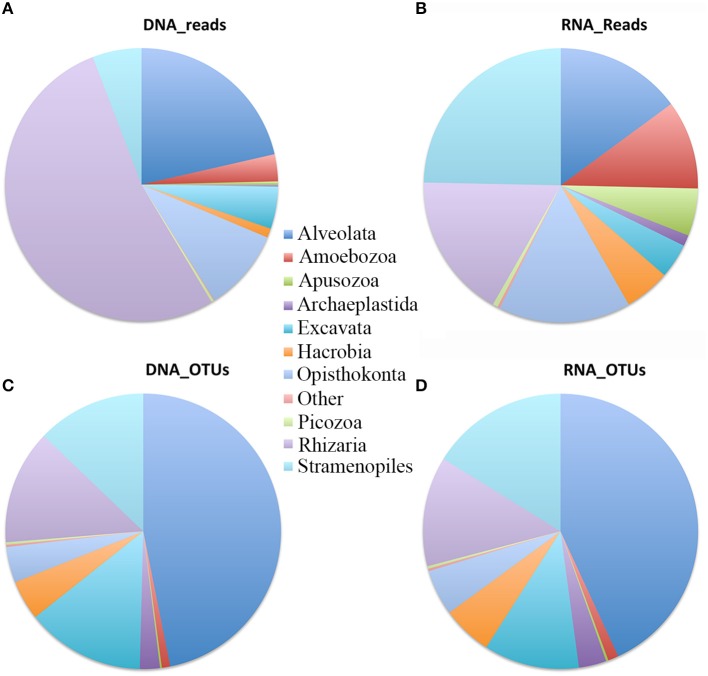
Overview of assemblages of microbial eukaryotes in the South China Sea water column at the supergroup taxonomic level. Relative sequence number in DNA survey (A) and RNA survey (B); relative OTU number in DNA survey (C) and RNA survey (D).